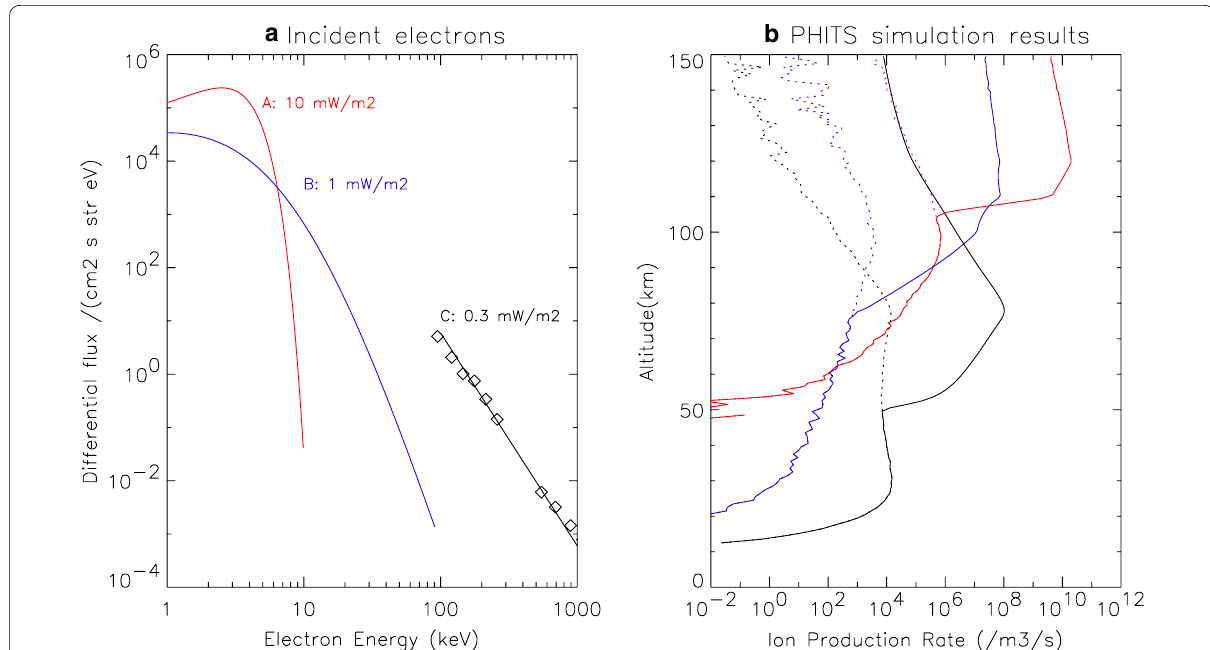
Fig. 5 Incident electron energy spectra (left) and their ion production rate in the atmosphere (right) over Syowa Station obtained from the PHITS simulation. The red lines represent broadband electrons associated with discrete auroras in model A, the blue lines represent the diffuse pulsating auroras in model B, and the black lines represent the energetic electrons in model C. Peak HEP and XEP omnidirectional flux values are depicted by diamonds. The contributions of X-rays are shown by dotted